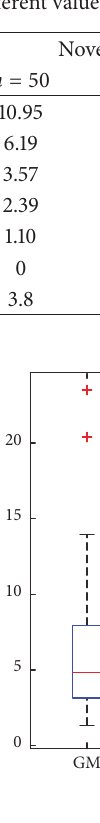
Figure 10: Box plot of RMSEs at different values of 𝑝 in the novel GM and